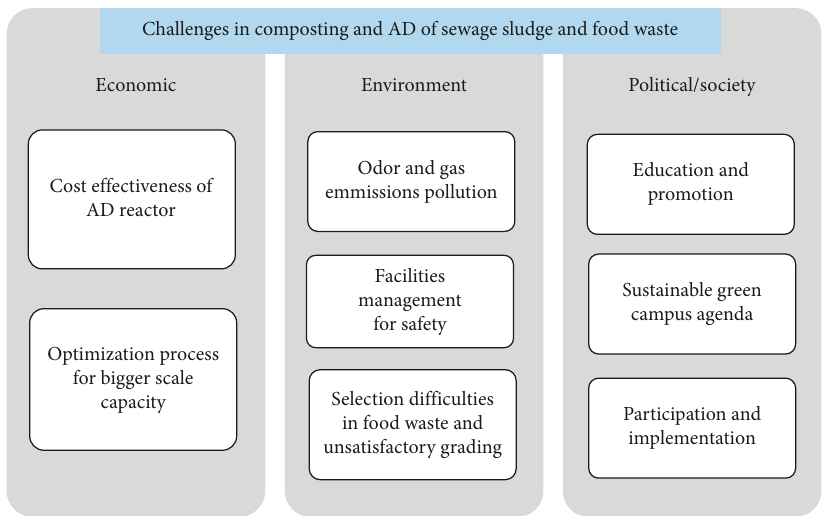
Figure 2: Challenges in the adaptation of composting and AD in